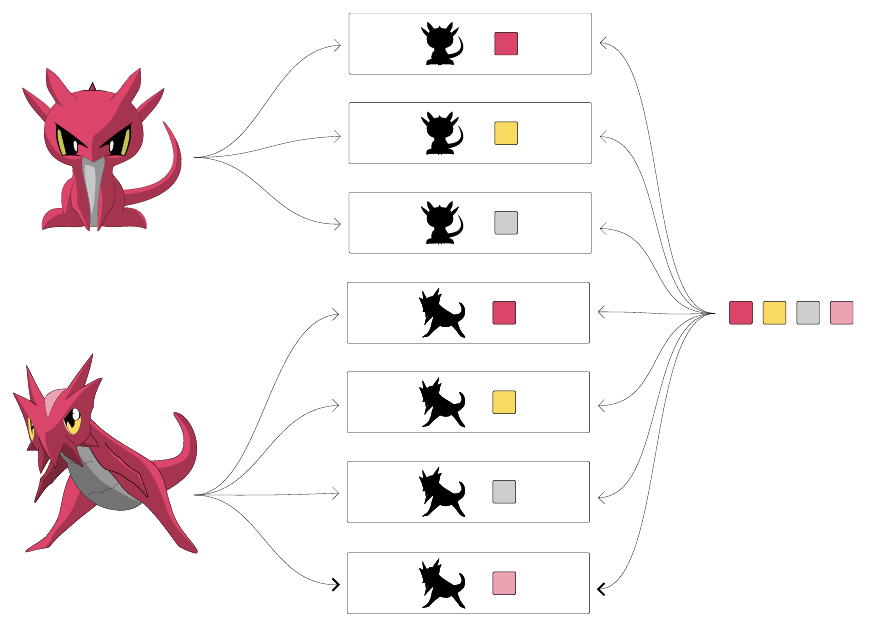
Fig 4. The colors of Clavis and Clavissima: The species Clavis and Clavissima both have several colors. In its default setting, the color character will allow the user to select only one color, which will imply that the individual does not have the other colors. By defining the character as non-exclusive, the user can pick and/or exclude freely from the list of possible